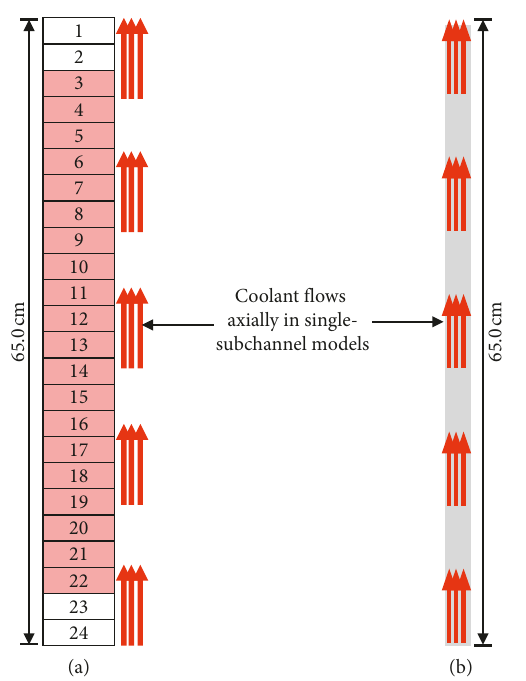
Figure 17: Two-dimensional flow direction predicted by (a) RELAP5/MOD3.3 and (b) COMSOL models.